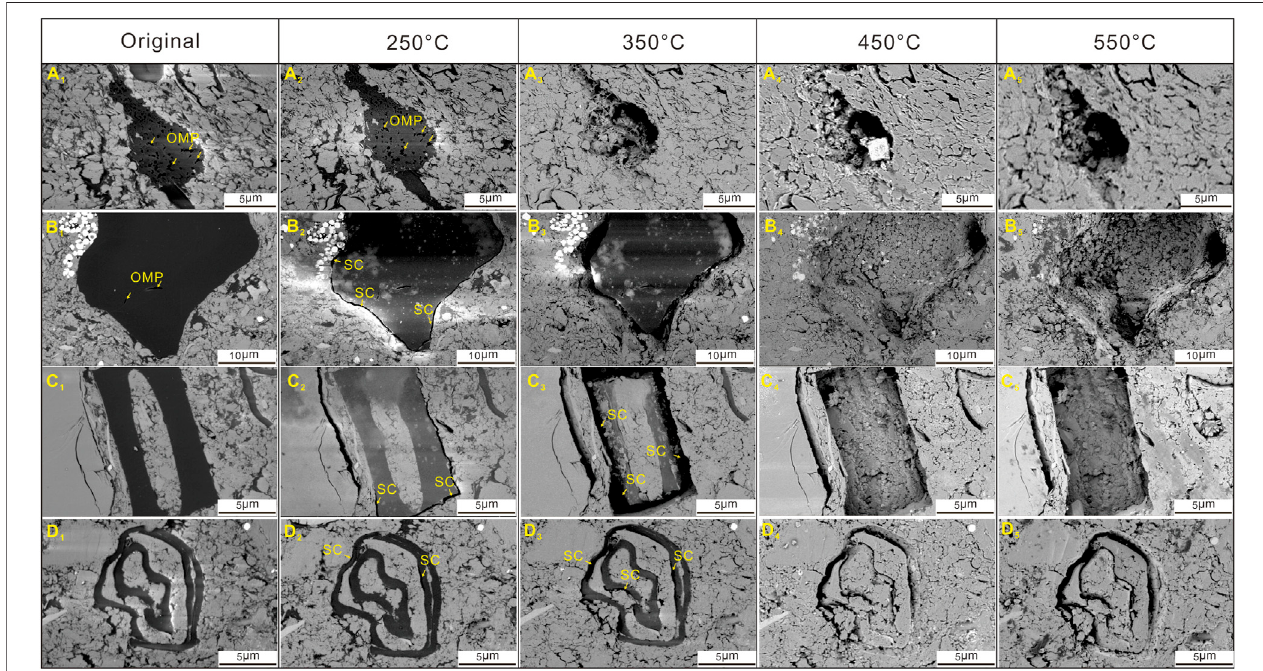
FIGURE 6 | SEM images of OM at different temperatures. OMP-OM pores, SC-shrinkage crack.